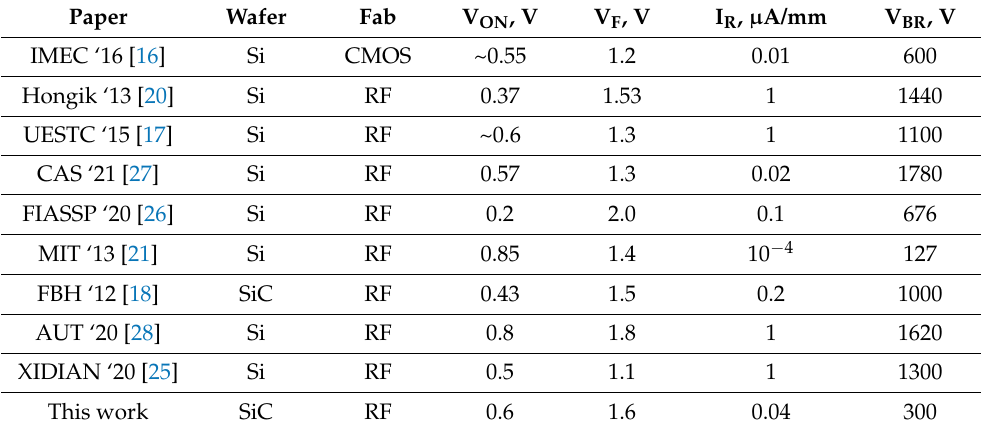
Figure 6. Experimentally measured reverse I-V characteristics of optimal SBDs at different operation temperatures. Table 3. Comparison of forward and reverse currents on different types of heterostructures.